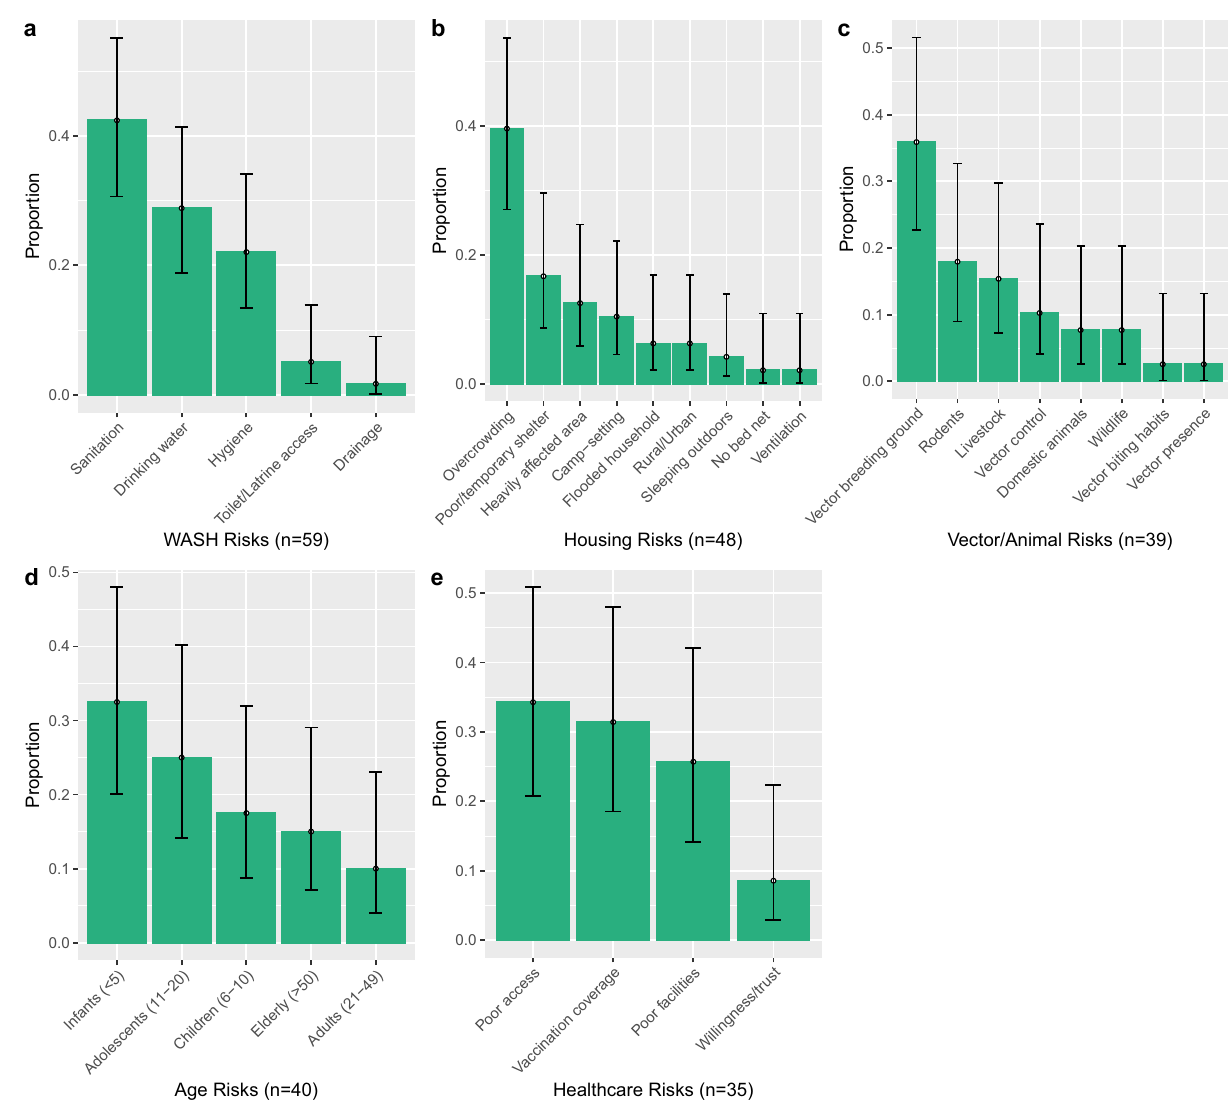
Figure 6. The most commonly reported risk factor clusters ( a ), WASH, ( b ), Housing ( c ), Vectors/Animals ( d ), Age and ( e ), Healthcare, split into the proportion of individual reported risk factors, with binomial confidence intervals (95%). Although displacement was the highest, it was not included as it had few elements within the